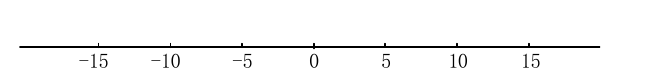
Figure 3. Position distribution of physical sensors and virtual sensors ( M = 4, N =